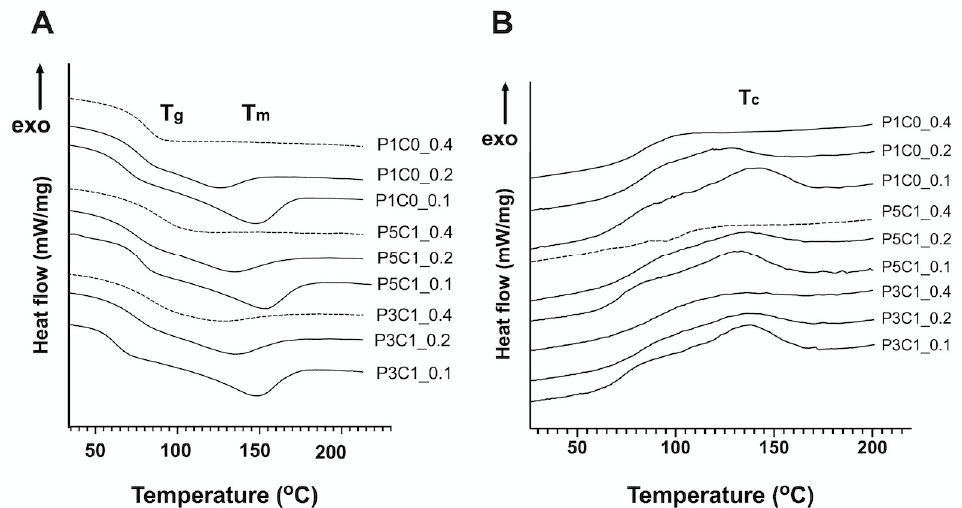
Figure 3. Differential scanning calorimetry (DSC) thermal analysis of scaffolds (exo up). P1C0 control, P5C1, and P3C1 scaffolds with different GA/PVA crosslinking ratios of 0.4, 0.2, and 0.1. ( A ) Heating curves and ( B ) cooling curves; dashed lines in the heating curves indicate three groups without T m peaks (GA/PVA crosslinking ratio of 0.4). The dashed line in cooling curve indicates the group without T c peak (P5C1_0.4). P1C0 is PVA/CMC = 1:0; P5C1 is PVA/CMC = 5:1; P3C1 is PVA/CMC = 3:1.